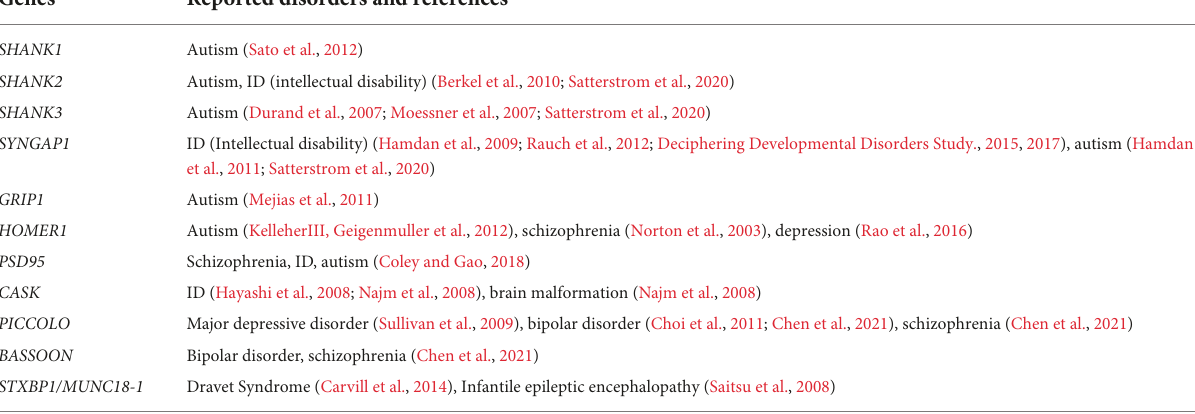
TABLE 1 Scaffold proteins that have been reported to be associated with neurological or psychiatric disorders from human genetics